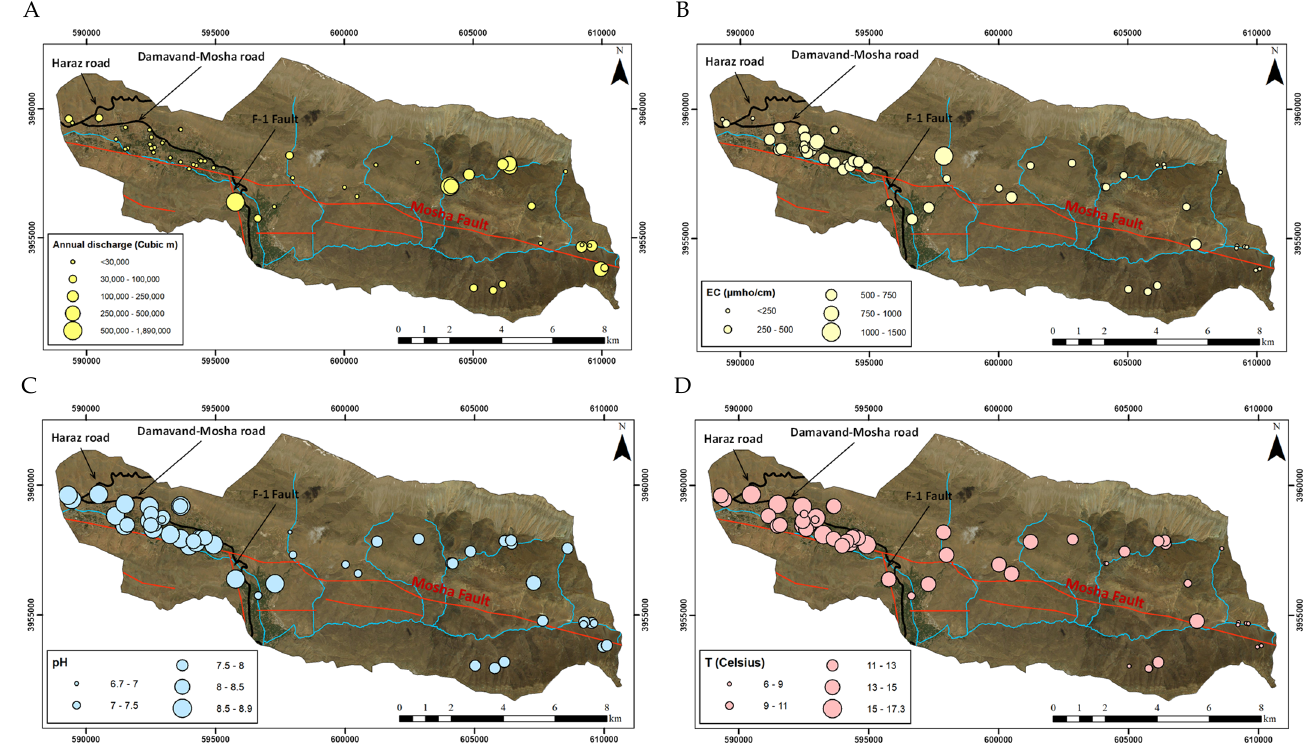
Figure 5. Quantitative and qualitative characteristics of springs in the study area. Solid black lines represent major inter ‐ city roads: ( A ) the springs’ water annual discharge; ( B ) the springs’ water electrical conductivity; ( C ) the springs’ water acidity; ( D ) the springs’ water temperature.